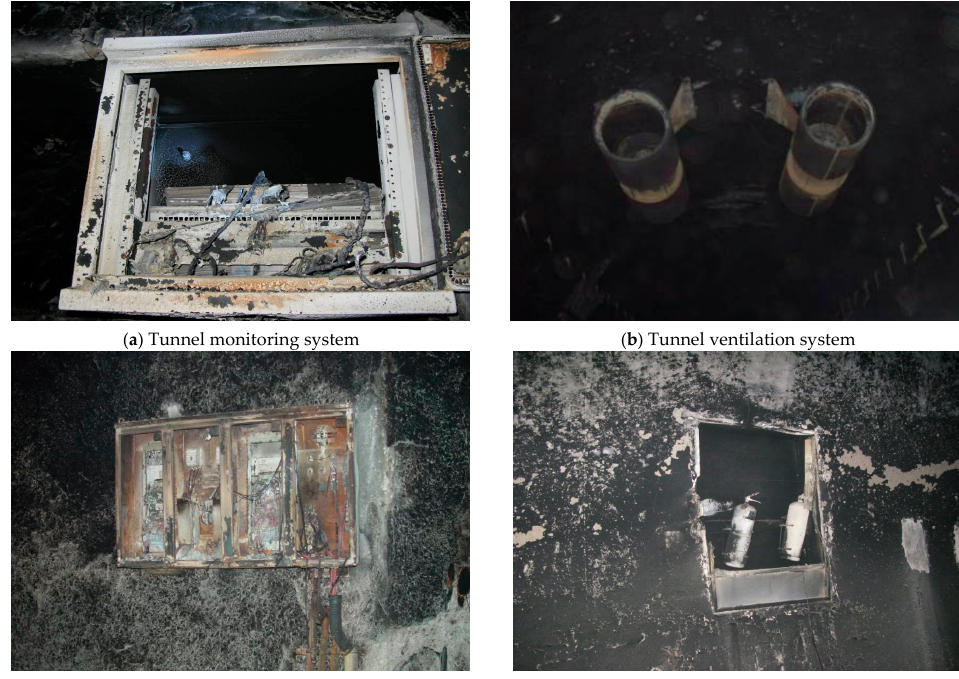
Figure 8. Damage to the affiliated facilities in the tunnel.